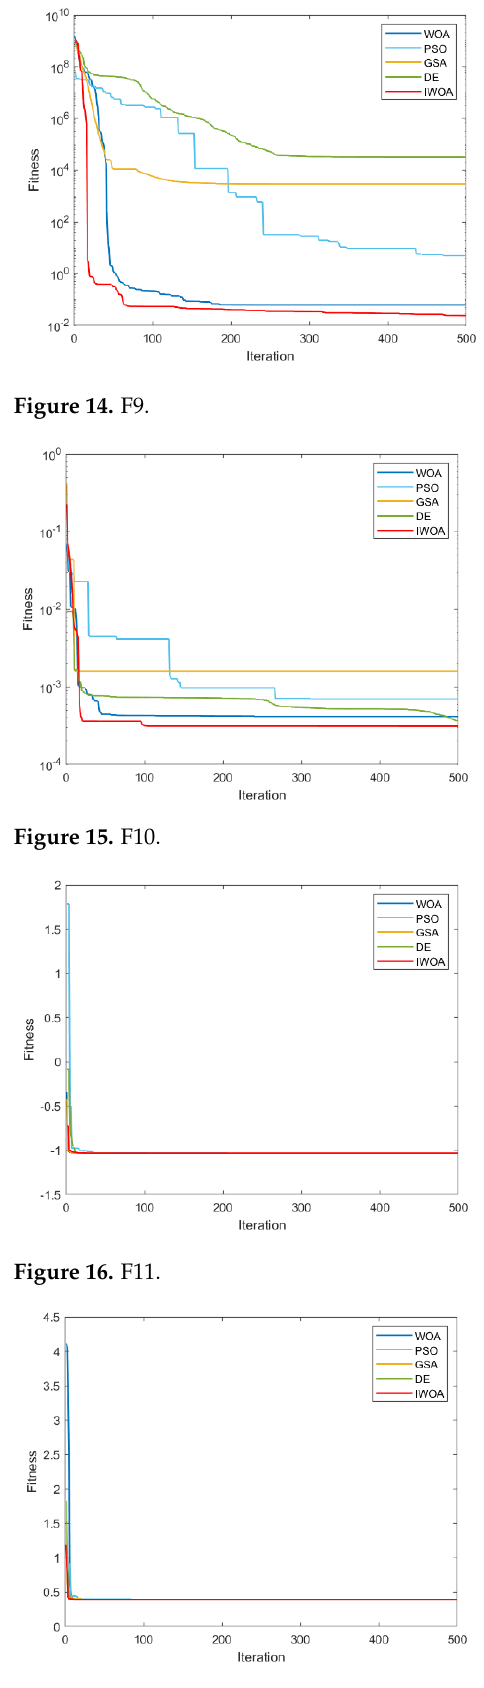
Figure 17. F12. Figure 17.